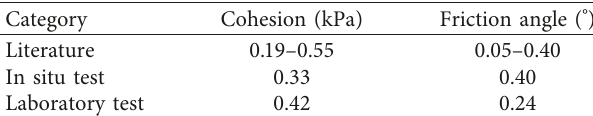
Figure 14: Percentage of particles smaller than 0.5mm and the cohesion versus the elevation of test location. Table 6: Cohesion and friction angle variation coefficients of